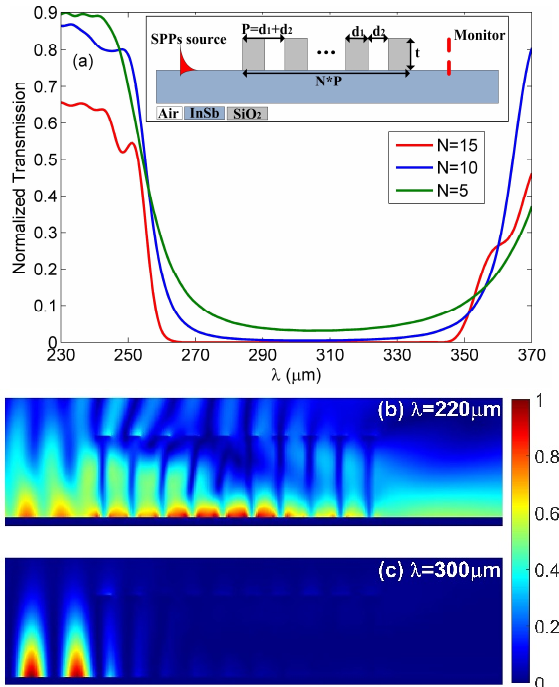
Figure 3. ( a ) Normalized transmission spectra of Bragg gratings with different number of period N. Inset: schematic view of Bragg reflector. Contour profiles of energy density at different incident wavelength of ( b ) λ = 250 μm and ( c ) λ = 300 μm.